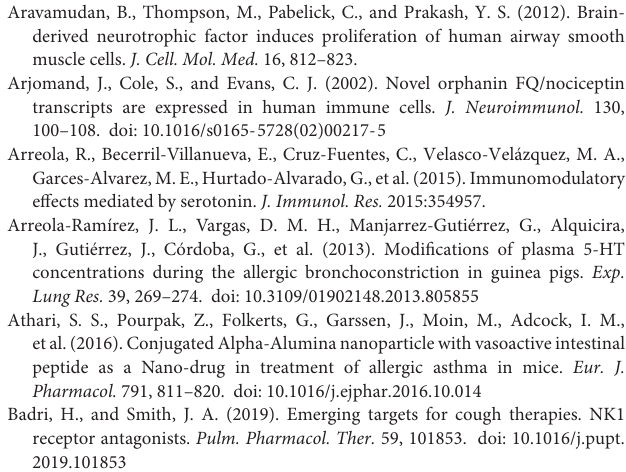
and figure elaboration. FR-J: manuscript redaction. LT: review of literature, manuscript